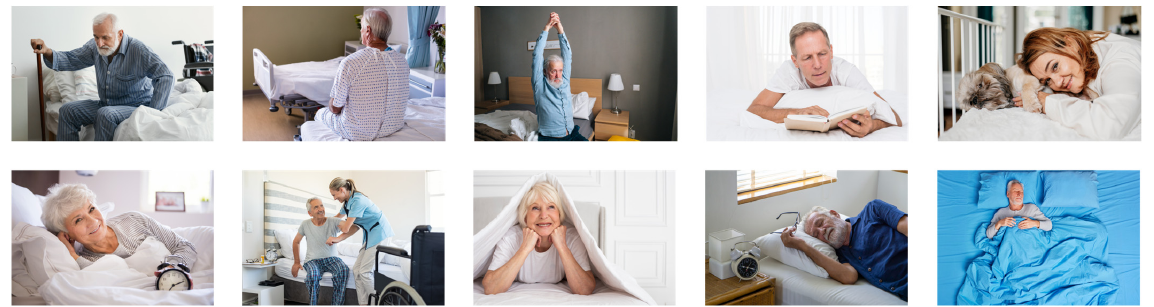
Figure 2. There is a huge variety of possible static and/or dynamical activities of a human in bed, which are monitored through a sensor system such as the one presented in Figure 1. The intelligent system to process the sensor data is capable of detecting and, eventually, also predict normal activ- ities and abnormal ones. (Source of the different image parts: